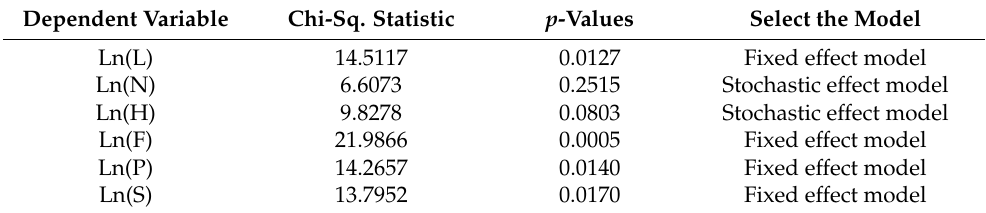
Table 3. Hausman test